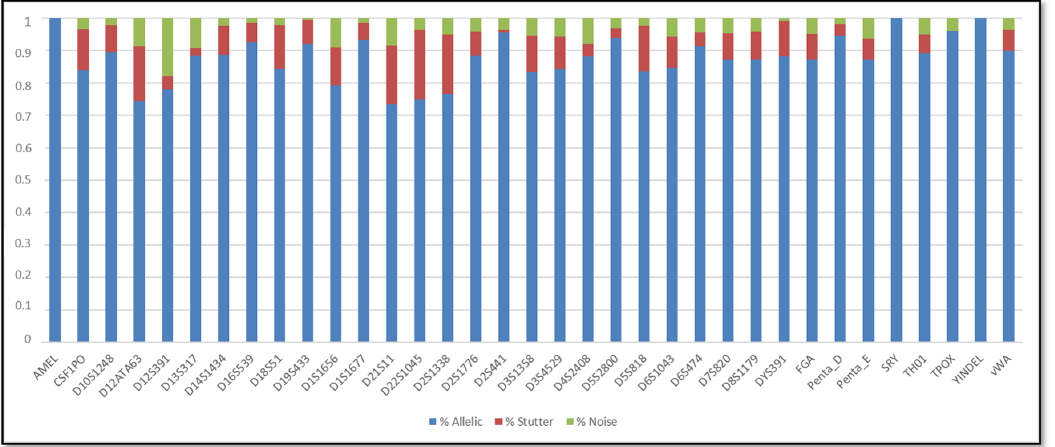
Figure 3. Sequence coverage ratios of the buccal swab mixtures.